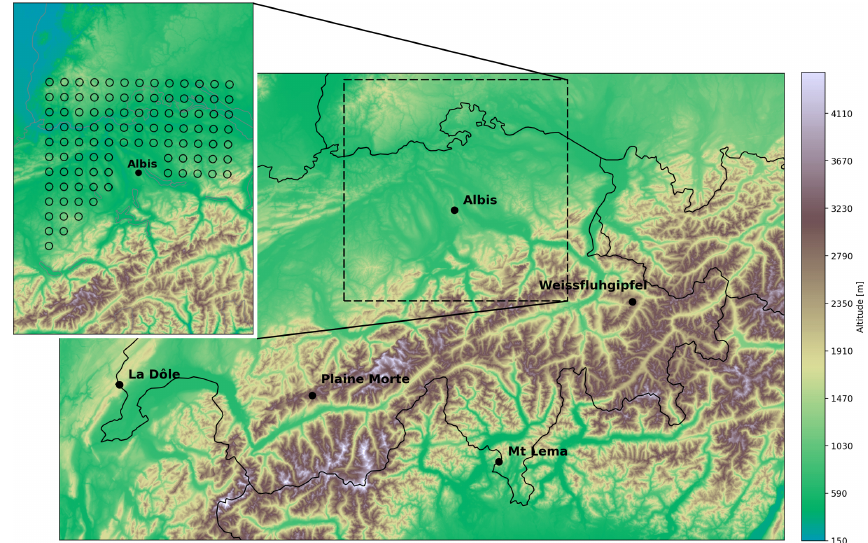
Figure 1. Location of the Albis radar within Switzerland overlaid on the digital elevation model (DEM; Jarvis et al., 2008) and the regular grid for the vertical cone extraction.